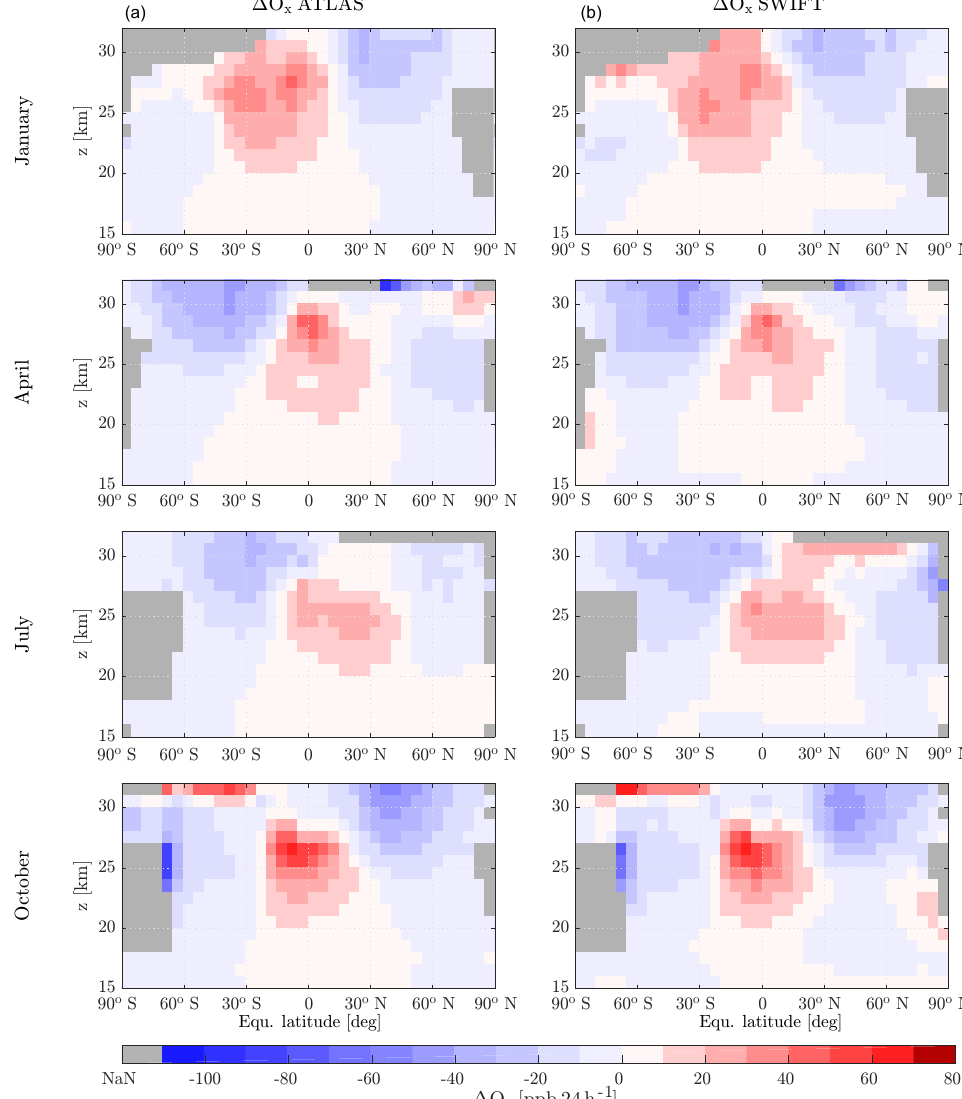
Figure 3. Zonal and monthly mean of (cid:49) O x from the testing data sets for four representative months. (a) ATLAS (cid:49) O x and (b) the result of the SWIFT polynomial functions evaluated at the testing data. Grey bins contain no or too little